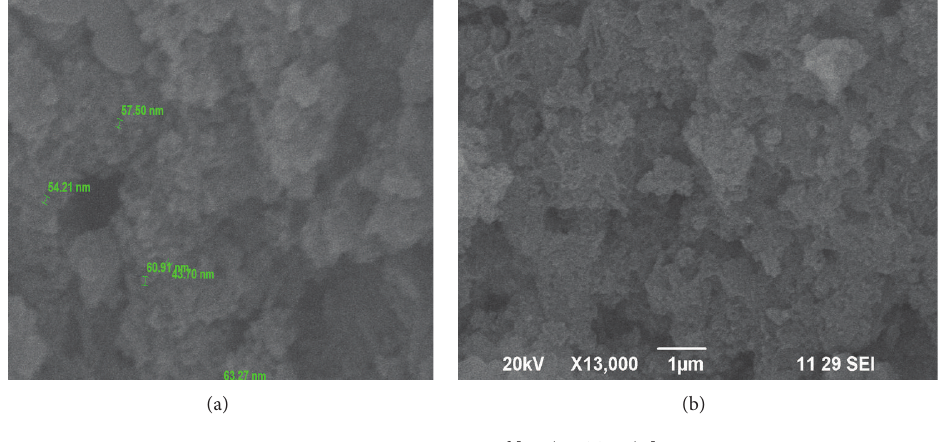
F 8: SEM images of [Cu(CDTMP)